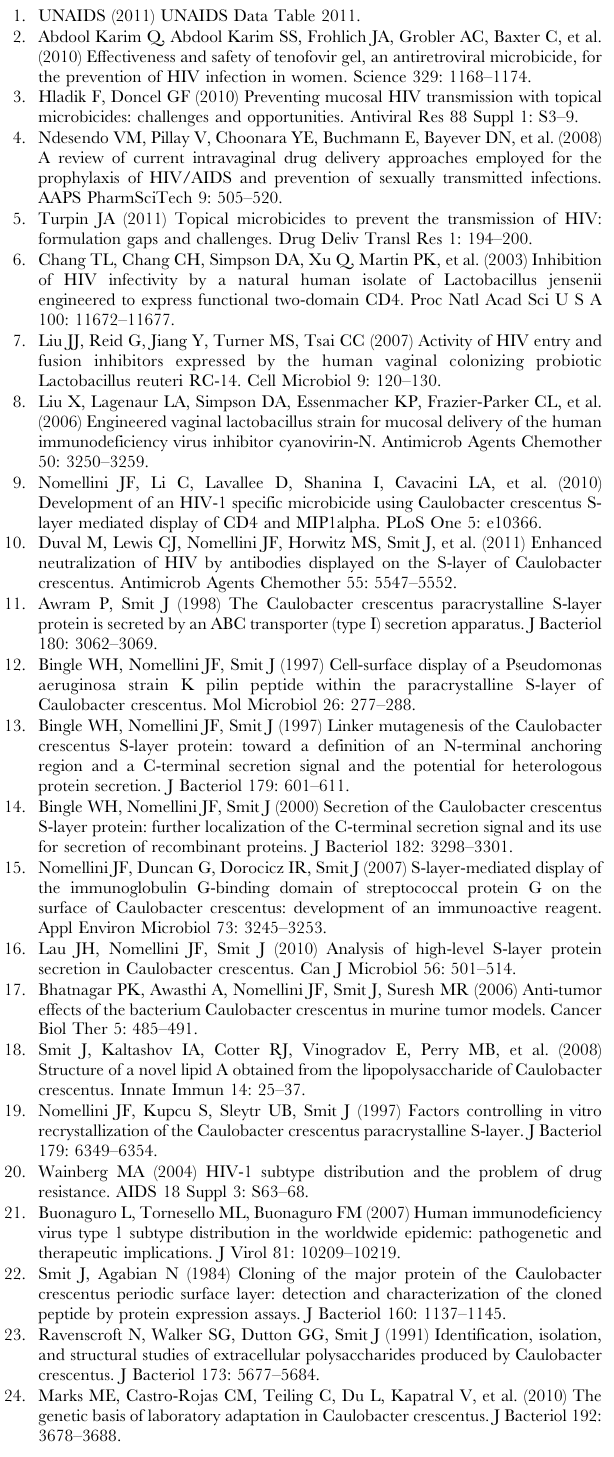
Table S1 JS4026 and JS4038 strains were compared side-by- side in the described viral blocking assay. Results represent mean with the range provided. Experiments were set up in quadruplicate and performed a minimum of 3